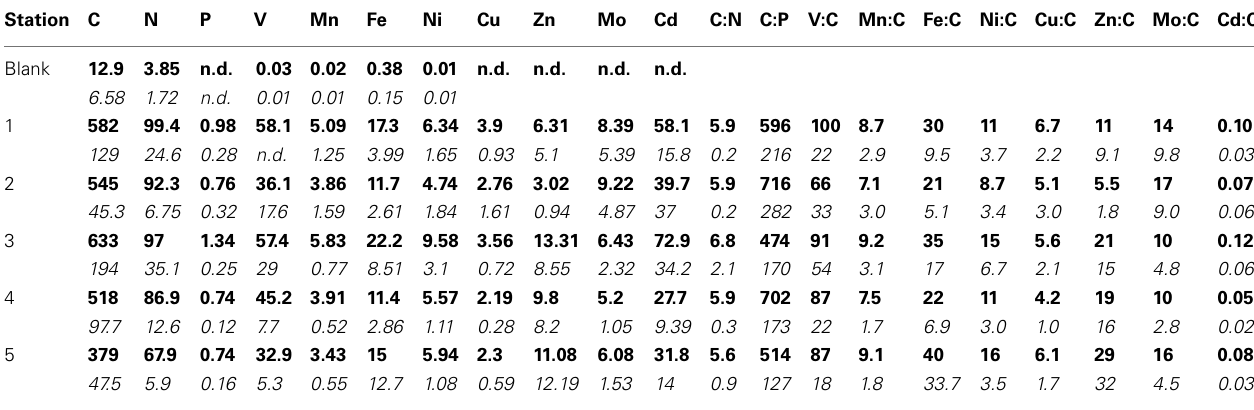
Table 2 | Mean element quotas measured by CHN and ICP-MS for Trichodesmium colonies collected from the Sargasso Sea. Station